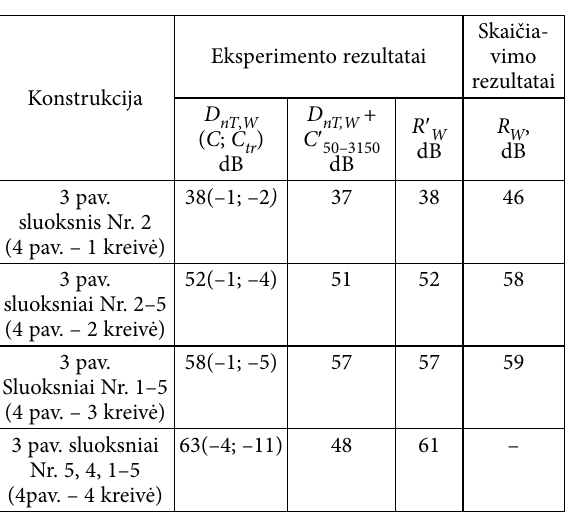
indicator with Fig. 4. The correlation of readings of D nT respect to curve 55 dB (dotted curve) with frequency (see Fig. 3): 1 – for layer No. 2; 2 – for layers No. 2–5; 3 – for layers from 1–5; 4 – bilateral; cover made of layers No. 5 and 4, further layers No. 1–5